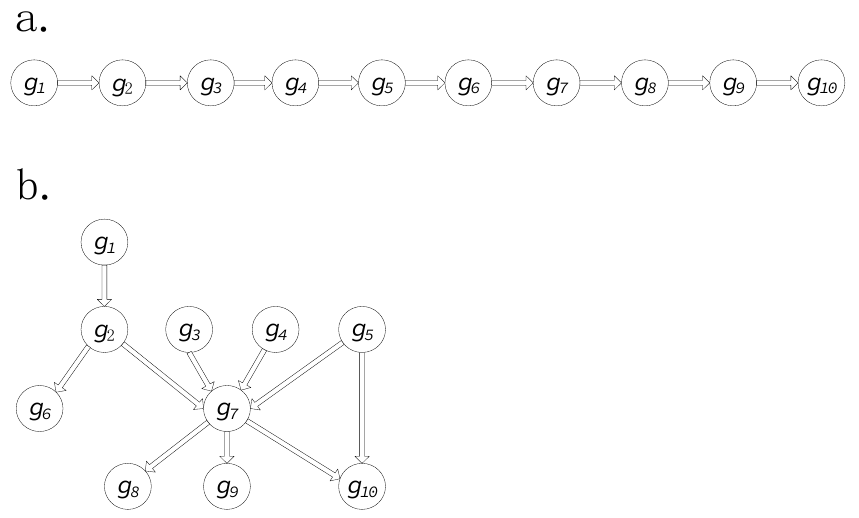
Figure 3. Two types of pathway structures: ( a ) the cascade structure, and ( b ) the complex structure used in simulation data.